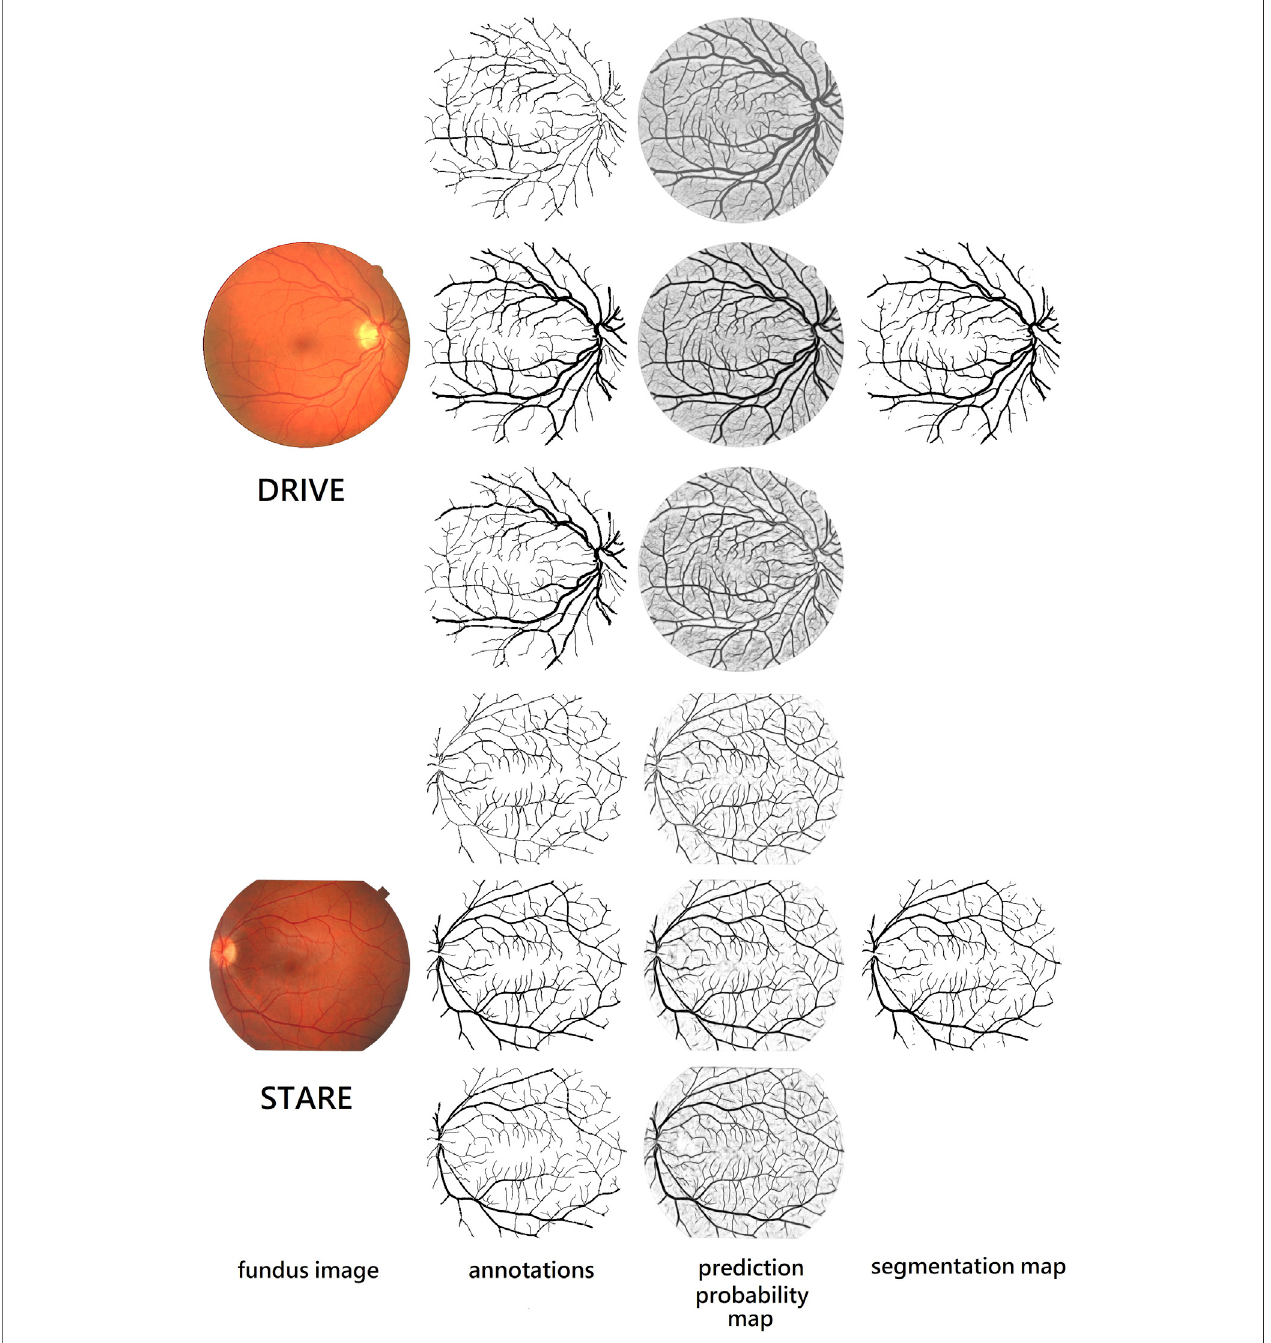
FIGURE 12 | Performance on retina vessel segmentation. From the top to bottom: images from DRIVE and STARE. From the left to right: fundus retina images, ground truths of thin, original, and thick vessels, and prediction probability maps of thin, original, and thick vessels, and binary segmentation map.